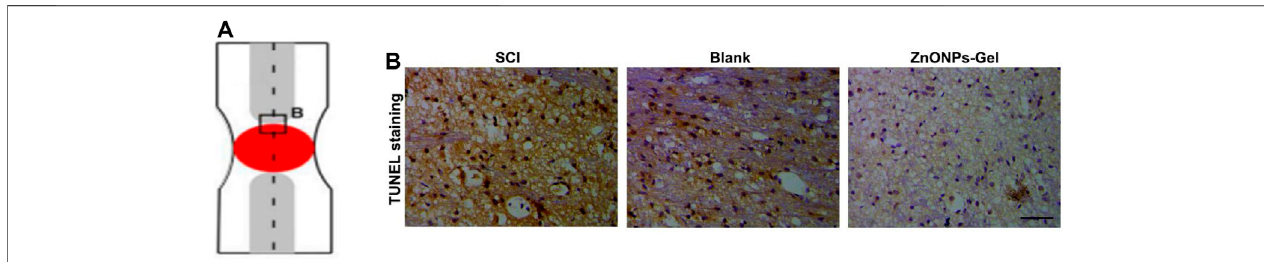
FIGURE7 | ZnONPs-Gel decreased injured spinal cord tissue apoptosis after SCI. Model ofinjured spinal cord (A) . TUNEL staining (B) in theinjured spinal cord of SCI group, blank group, or ZnONPs-Gel group at 7 days during the acute course of SCI. Scale bar (cid:2) 100 μ m.